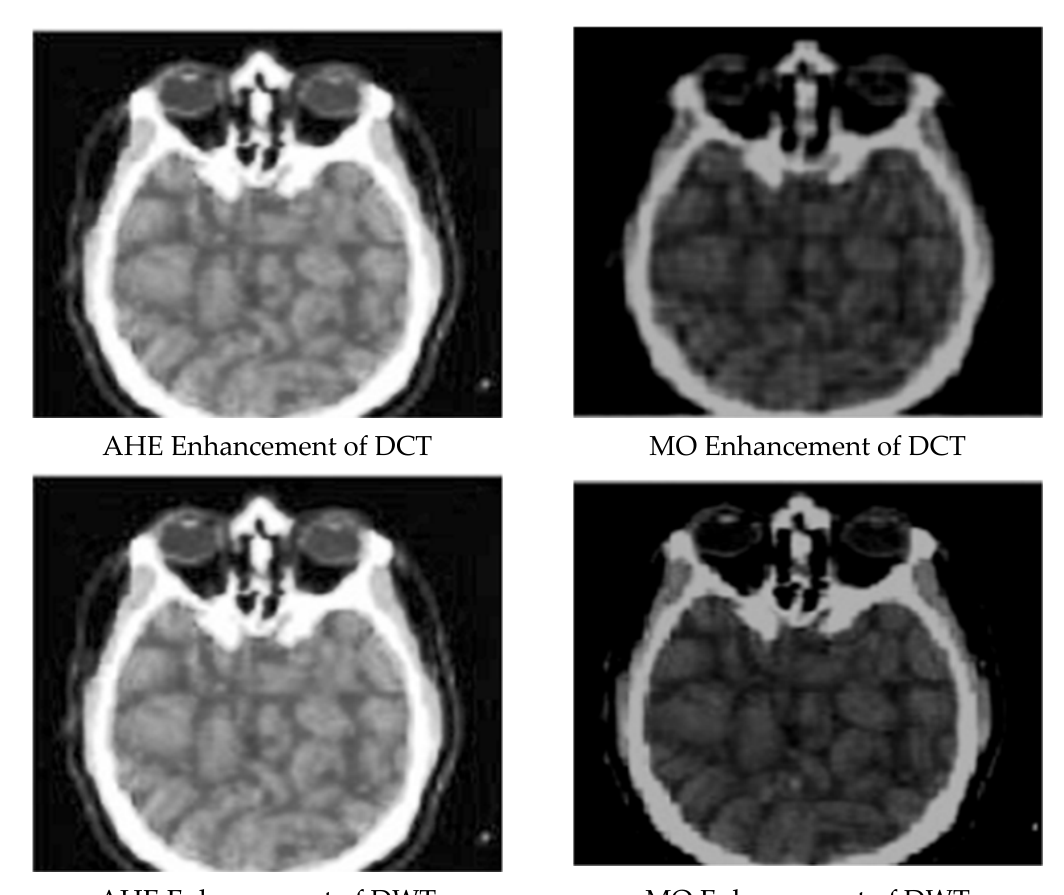
Figure 1. Lossy techniques: DCT and DWT compression.